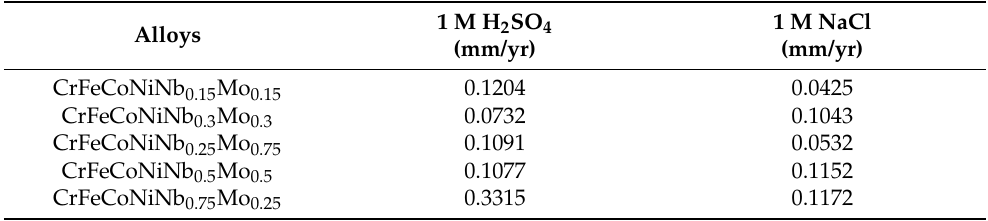
Table 9. Corrosion rates of the as-cast alloys in deaerated 1 M H 2 SO 4 and 1 M NaCl solutions at 30 ◦ C.